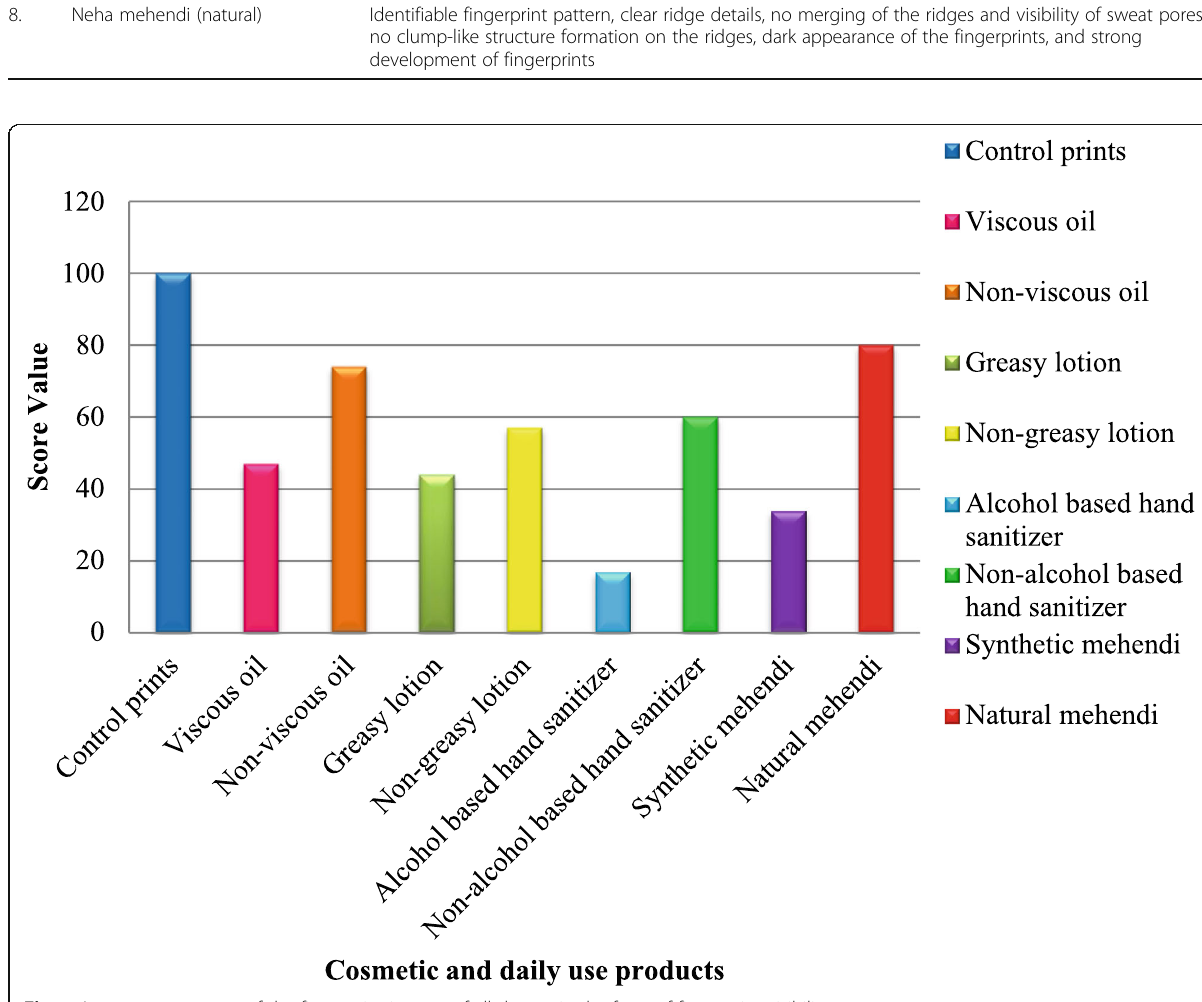
Fig. 4 Average assessment of the fingerprint images of all donors in the form of fingerprint visibility